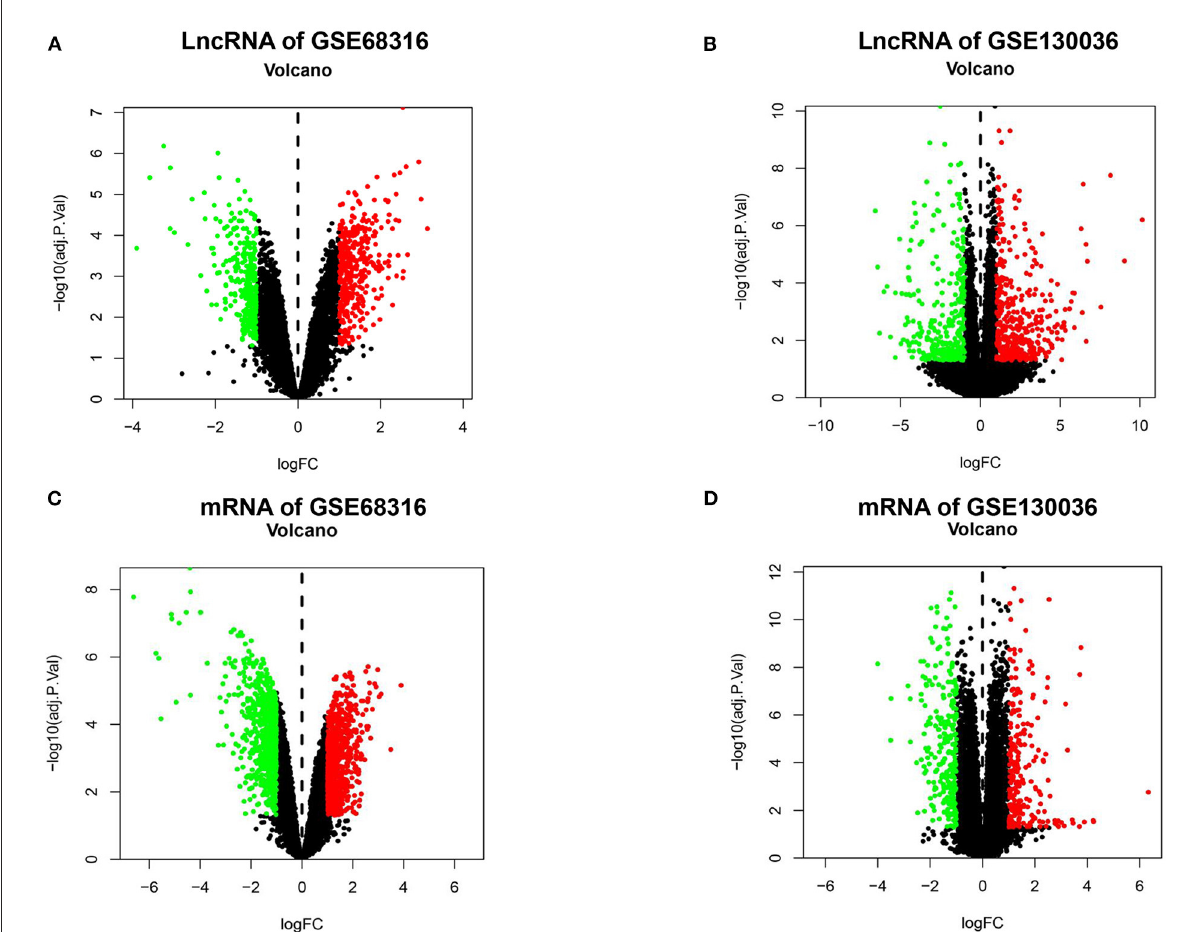
FIGURE1 A Volcano plot of all the differentially expressed lncRNAs and mRNAs between patients with HCM and the controls. (A) A volcano plot of differentially expressed lncRNAs in the GSE68316 dataset. (B) A volcano plot of differentially expressed lncRNAs in the GSE130036 dataset. (C) A volcano plot of differentially expressed mRNAs in the GSE68316 dataset. (D) A volcano plot of differentially expressed mRNAs in GSE130036 dataset. Green dots represent differentially expressed genes with log-fold change < -1, red dots represent differentially expressed genes with log-fold change > 1, and black spots represent genes with no significant difference in expression, adjusted p -value <